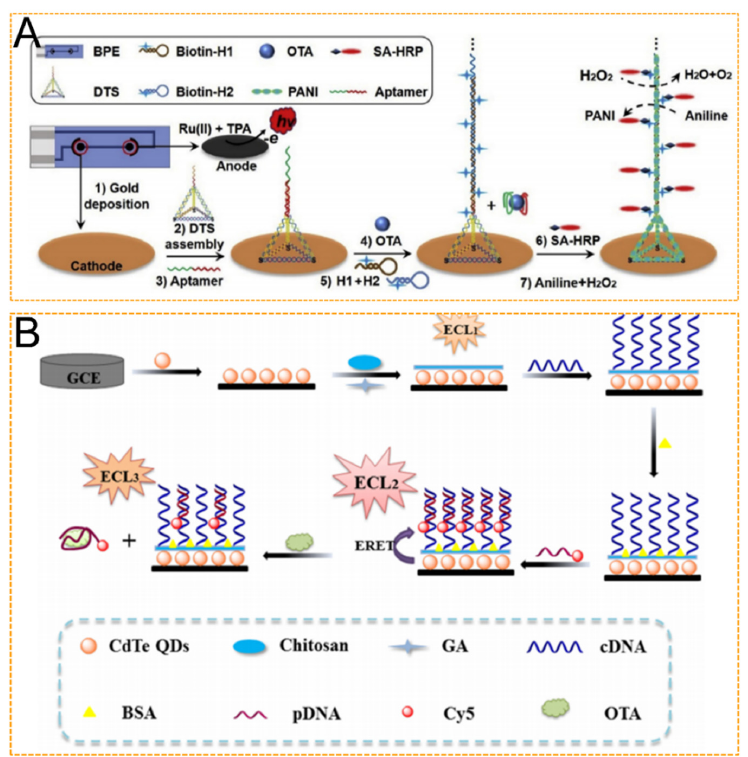
Figure 3. ( A ) Scheme of bipolar electrode ECL biosensor for OTA detection. Reproduced with per ‐ mission from Ref. [48]. Copyright 2021, Elsevier. ( B ) Scheme of ECL aptasensor for OTA detection